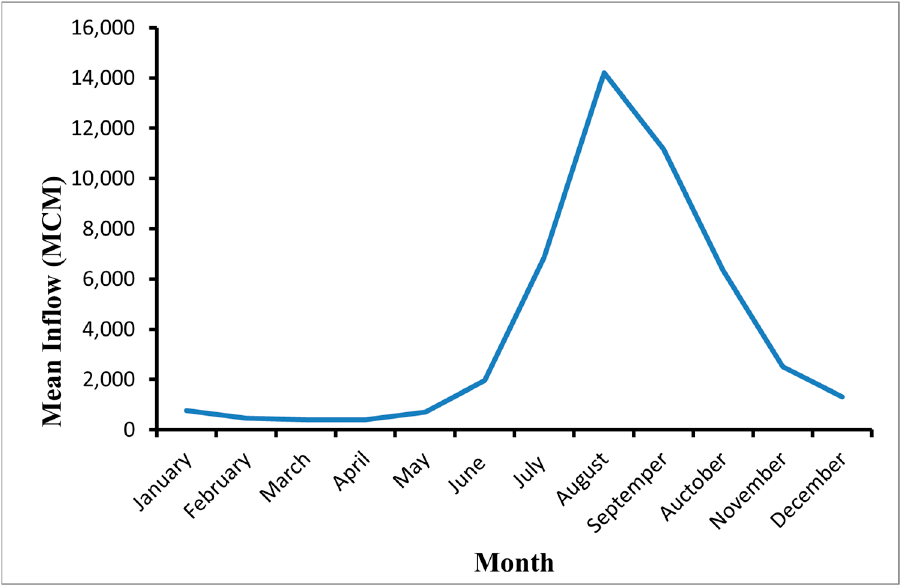
Figure 3. In fl ow hydrograph for the GERD. Figure 3. Inflow hydrograph for the